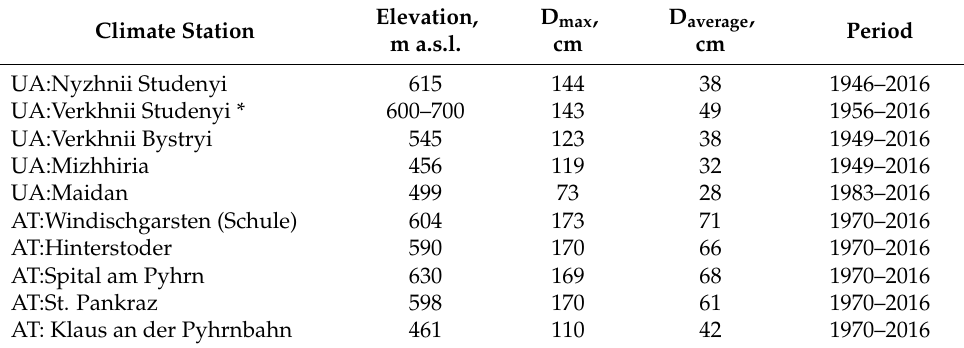
Table 4. The list of stations with snow depth observation (D) in the Steyr River Basin (Austria, AT) and Rika River Basin (Ukraine,